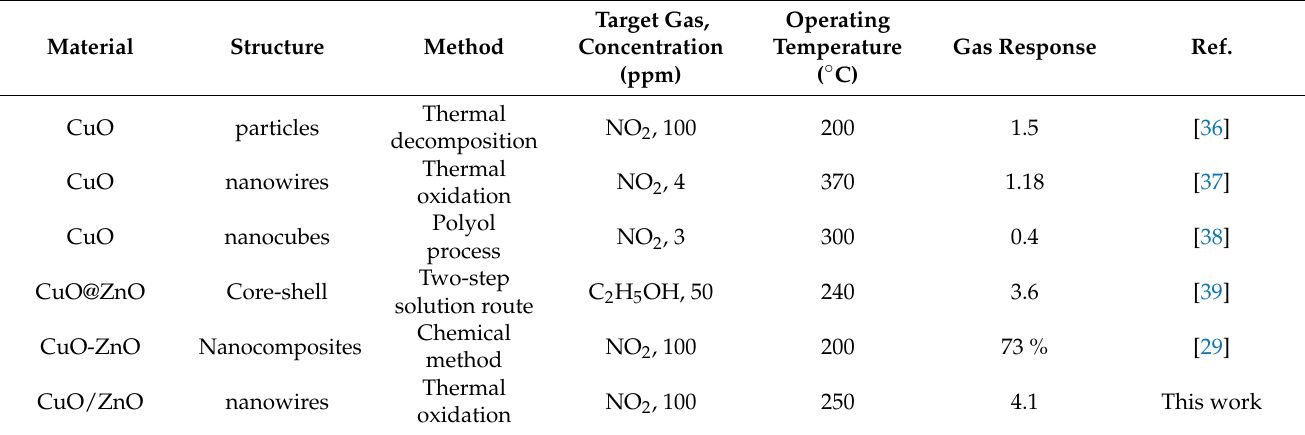
Figure 11. ( a ) Continuous response curves; ( b ) Response of the 0.05 M CuO/ZnO gas sensor to NO 2 at different concentrations of NO 2 (1 − 100 ppm) at 250 °C. Table 4. Brief summary of the response of CuO-based gas sensors.